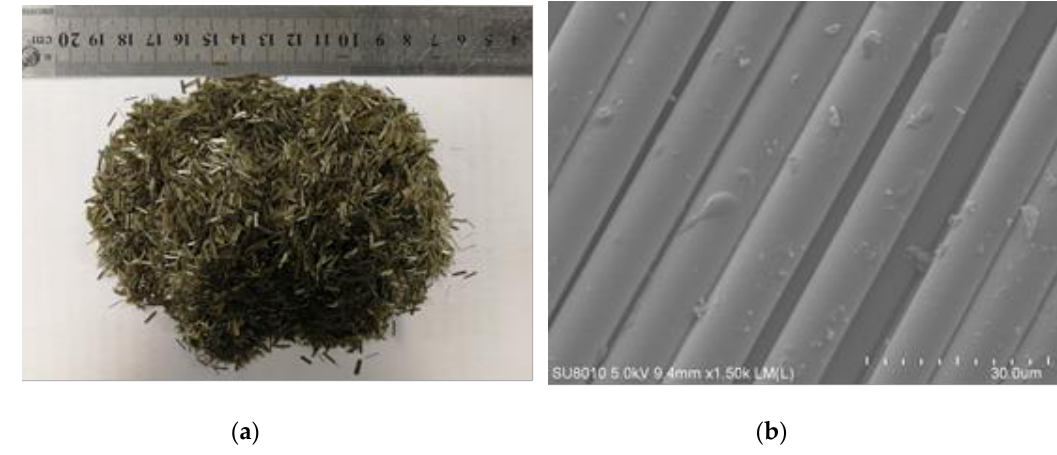
Figure 1. Basalt fibers: ( a ) Macroscopic; ( b ) microcosmic.